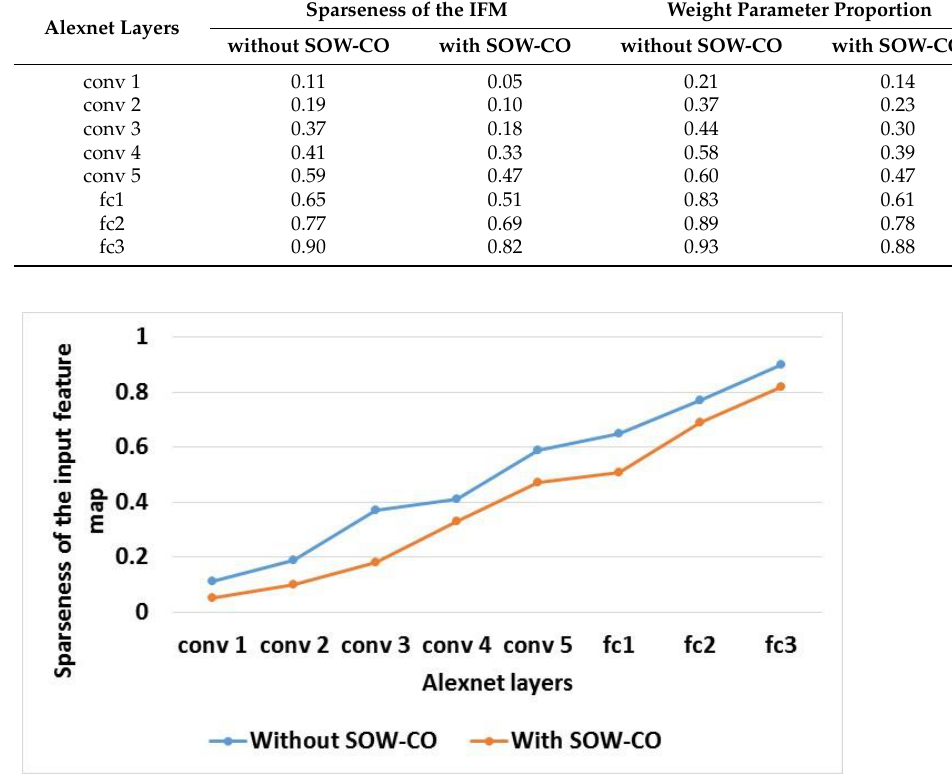
Figure 15. Graphical illustration of IFM’s sparseness for Alexnet.